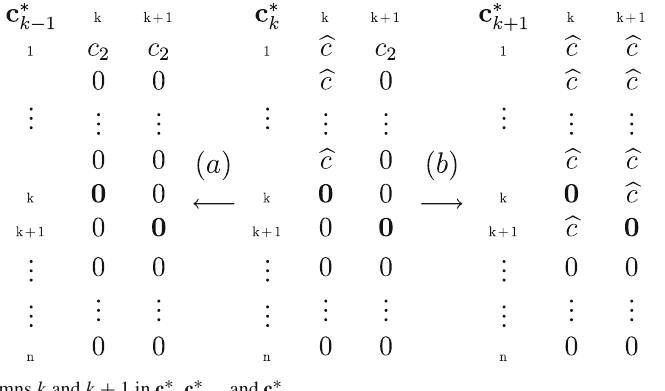
Fig. 9 Columns k and k + 1 in c ∗ k , c ∗ k −